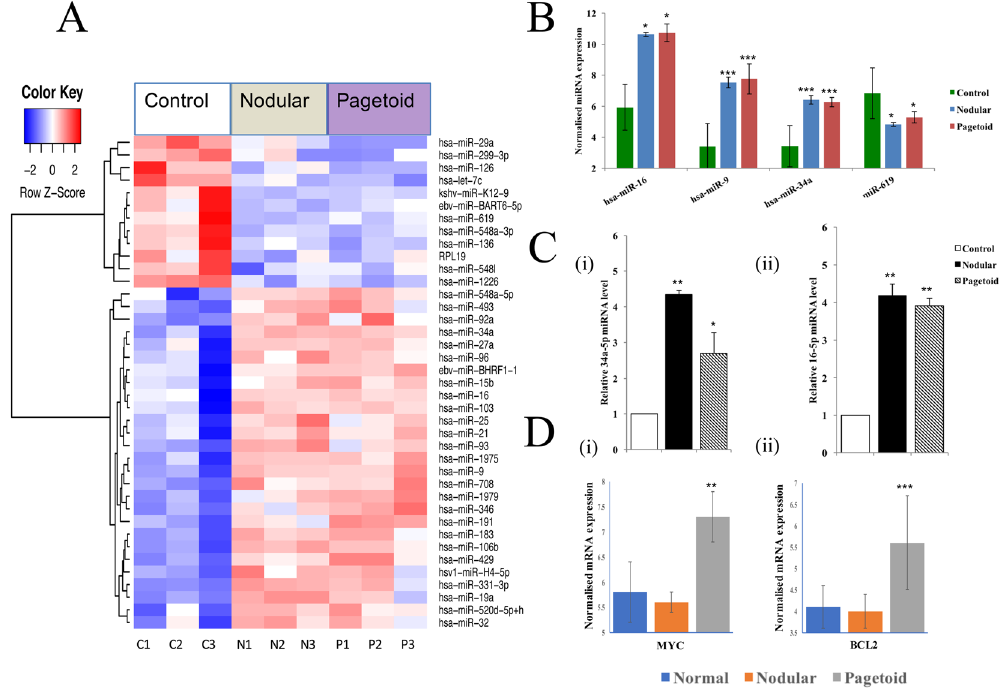
Figure 1. Shared microRNAs in nodular and pagetoid sebaceous gland carcinoma (SGC). ( A ) Thirty-nine significant differentially expressed microRNA shared between both subtypes using a p < 0.05 threshold. ( B ) Top 4 differentially expressed miRNAs present in both nodular and pagetoid SGC when compared to tarsal plate control. ( C ) MicroRNA verification of expression using Taqman RT-qPCR in SGC. Relative expression levels were determined for nodular and pagetoid SGC using Taqman RT-qPCR against normal eyelid tissue for miRNA (i) 34a-5p and (ii) 16-5p. ( D ) Expression of target genes in both nodular and pagetoid subtypes. Significance levels are shown as * P < 0.05, ** P < 0.01, *** P < 0.001. Error bars represent mean + / −